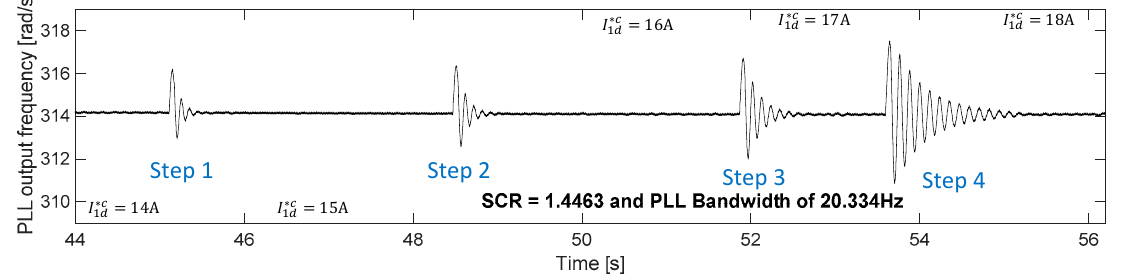
Figure 15. Transient response of frequency at the PLL output for a SCR of 1.4463 and for a PLL BW of 20.334 Hz, in the four steps considered in for the validation—MatLab data logging of the experimental waveforms. Table 7. Comparison between the damping of modes 7 and 8 given by the proposed model and the those found in the experimental system, for a SCR = 1.4463 and PLL bandwidth equal to 20.344 Hz. Table 1. Comparison between the damping of modes 7 and 8 given by the proposed model and the those found in the experimental system, for SCR = 1.6265 and PLL bandwidth equal to 30.898 Hz.